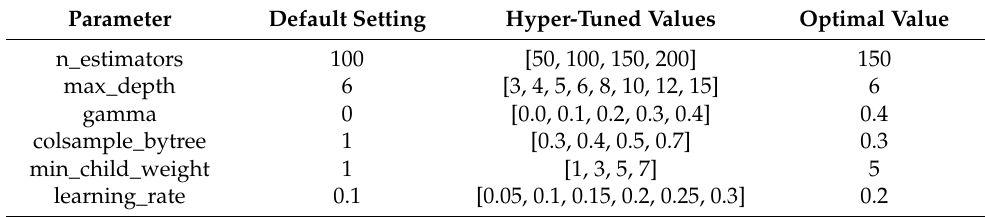
Table 2. Default and tuned values of parameters used in our study.